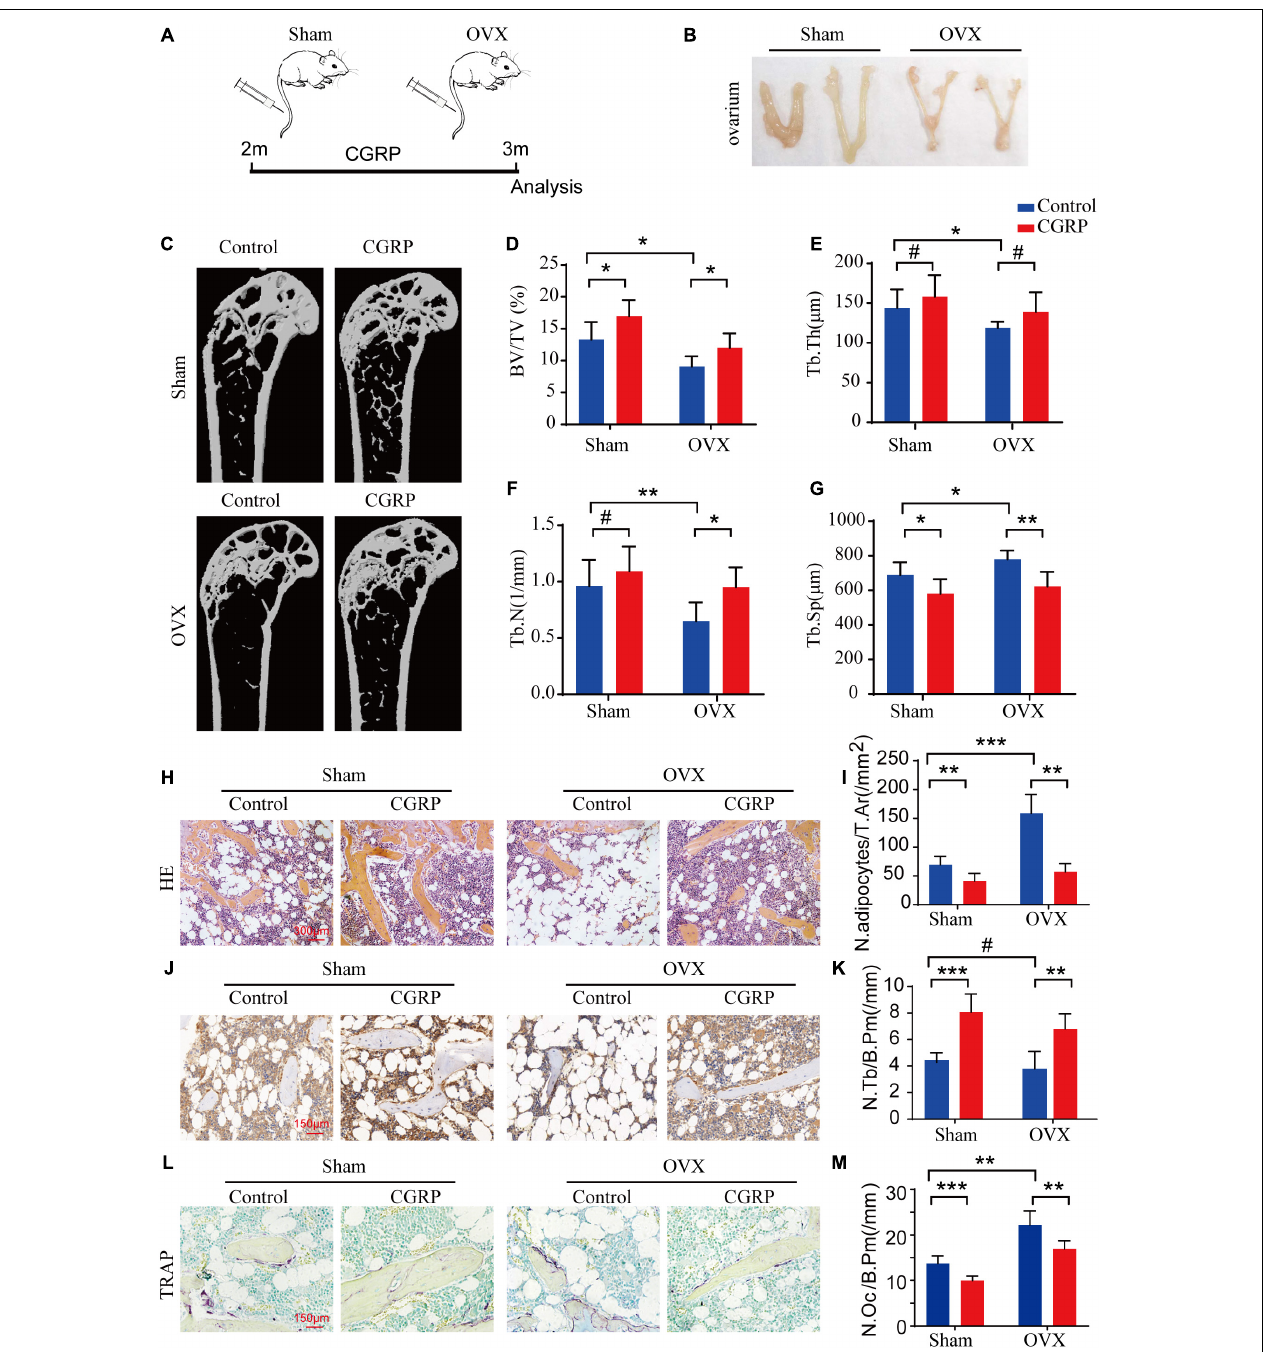
FIGURE 5 | CGRP treatment promoted bone formation in ovariectomized (OVX) mice. (A) A schematic representation of the injection protocol (CGRP or 1 × PBS via the tail vein) for OVX and control (sham-operated) mice. (B) Representative images of the ovaries of OVX and control (sham-operated) mice treated with or without CGRP. (C) Representative micro-computed tomographs ( n = 6/group) and (D–G) quantitative analysis of bone volume as a fraction of total bone volume (BV/TV), trabecular thickness (Tb. Th), trabecular number (Tb. N), and trabecular separation (Tb. Sp) of femora from OVX and control (sham-operated) mice treated with or without CGRP. (H) Representative images of hematoxylin and eosin staining and (I) quantitative analysis of the number and area of adipocytes in the bone marrow of OVX and control (sham-operated) mice treated with or without CGRP. Scale bar, 300 µ m. (J) Representative images of osteocalcin (OCN) staining and (K) quantification of osteoblast bone surface density (N.Ob/B.Pm) in the femora of OVX and control (sham-operated) mice treated with or without CGRP. (L) Representative images of tartrate-resistant acid phosphatase (TRAP) staining and (M) quantification of osteoclast bone surface density (N.Oc/B.Pm) in the femora of OVX and control (sham-operated) mice treated with or without CGRP. Scale bar, 150 µ m. Data are presented as means ± SEM. * P < 0.05, ** P < 0.01,*** P < 0.001. # means no statistical significance.